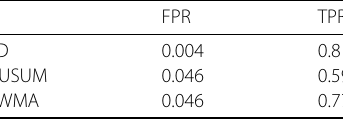
Table 1 The results of the maximum TPR among FPR ≤ 0.05. The TD is more accurate than the CUSUM and the EWMA for early outbreak detection of influenza FPR TPR TD 0.004 0.819 CUSUM 0.046 0.596 EWMA 0.046